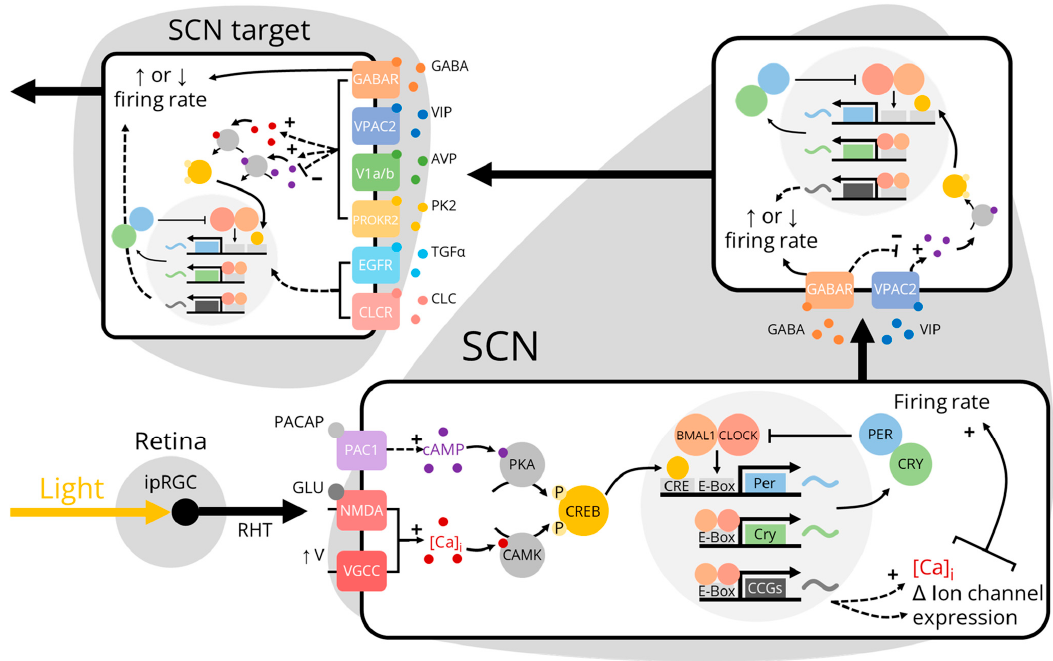
Figure 1. Photoentrainment of the SCN and SCN target neurons. Light activates intrinsically- photosensitive retinal ganglion cells (ipRGCs) which project through the retinohypothalamic tract (RHT) to release glutamate (GLU) and pituitary adenylate cyclase-activating peptide (PACAP) onto retinorecipient suprachiasmatic nucleus (SCN) neurons [9,10]. The activation of glutamate receptors increases intracellular calcium ([Ca] i ) directly through N-methyl D-aspartate (NMDA) receptors and indirectly through voltage-gated calcium channels (VGCCs) [11]. The activation of PAC1 receptors initiates a G protein cascade that increases intracellular cyclic AMP (cAMP). cAMP and [Ca] i activate protein kinase A (PKA) and calcium-dependent protein kinases (CAMK) to phosphorylate cAMP response element (CRE)-binding protein (CREB) [9,12]. Phosphorylated CREB promotes the tran- scription of the Period genes within the molecular circadian clock which increases the transcription of clock-controlled genes (CCGs) [13]. The translation of CCGs increases neuronal firing rate by directly increasing [Ca] i or by altering membrane ion channel expression [14–16]. Increased firing rate in retinorecipient SCN neurons increases the release of gamma-aminobutyric acid (GABA) and vasoac- tive intestinal peptide (VIP) onto other neurons in the SCN neural network [17,18]. This changes neuronal firing rate and transcription of core clock genes either directly through the activation of ionotropic GABAA receptors or indirectly through metabotropic GABAB receptors and the VIP receptor VPAC2 [19–21]. SCN output neurons subsequently release several output factors including GABA, VIP, arginine vasopressin (AVP), prokineticin 2 (PK2), transforming growth factor-alpha (TGF α ), and cardiotrophin-like cytokine (CLC) onto SCN target neurons [22–27]. These SCN output signals ultimately entrain SCN target neurons by changing their firing rates and core clock gene transcriptional